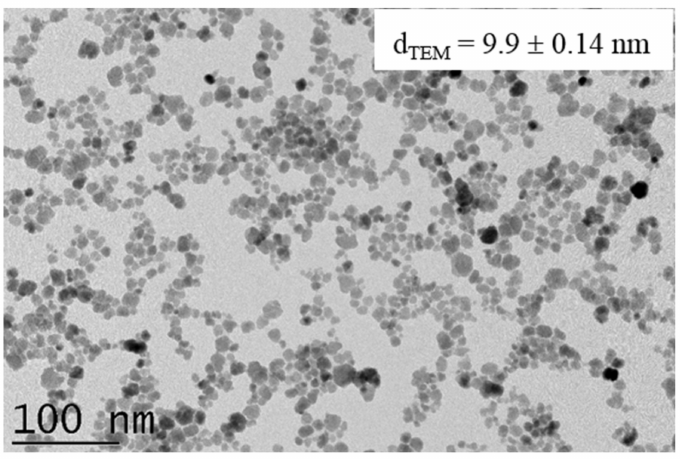
Figure 2. TEM image of γ -Fe 2 O 3 magnetic nanoparticles